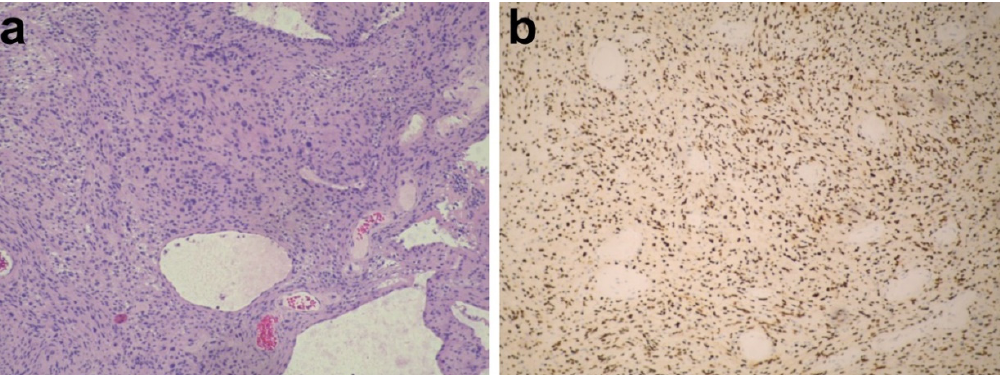
Figure 3. Histological features: ( a ) Hematoxylin and eosin (H&E) staining (original magnification × 100) showing the histological appearance of vestibular schwannoma; ( b ) immunohistochemistry showing positive reactivity for SRY-box transcription factor 10 (SOX10) (original magnification × 100).